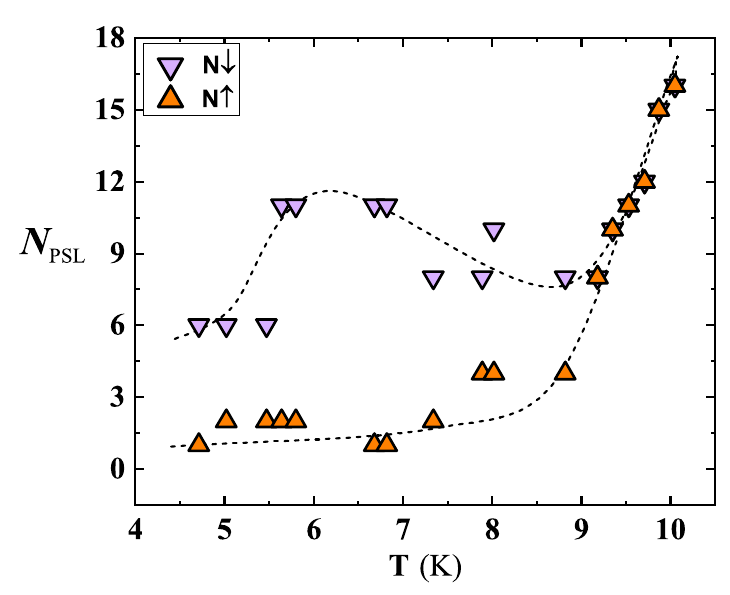
Figure 12. Number of resistive states for SR5, calculated from the I-V curves, during the current sweep-up ( N ↑ ) and sweep-down ( N ↓ ). Near to T (cid:39) 9 K, N ↑ and N ↓ suddenly converge, assuming the same value at T ≥ 9 K. Broken lines are guides for the